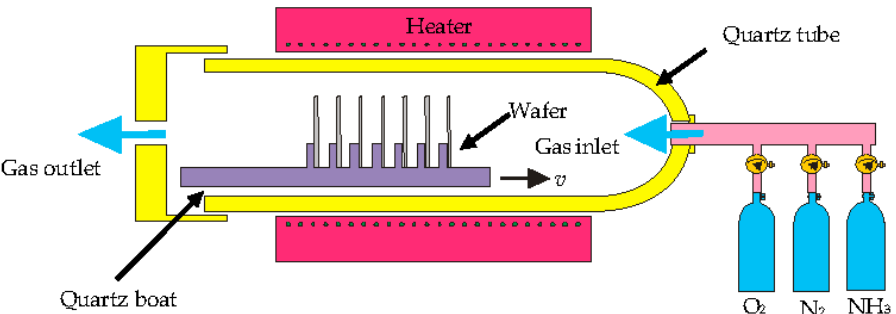
Figure 4. Schematic diagram of oxidation furnace.